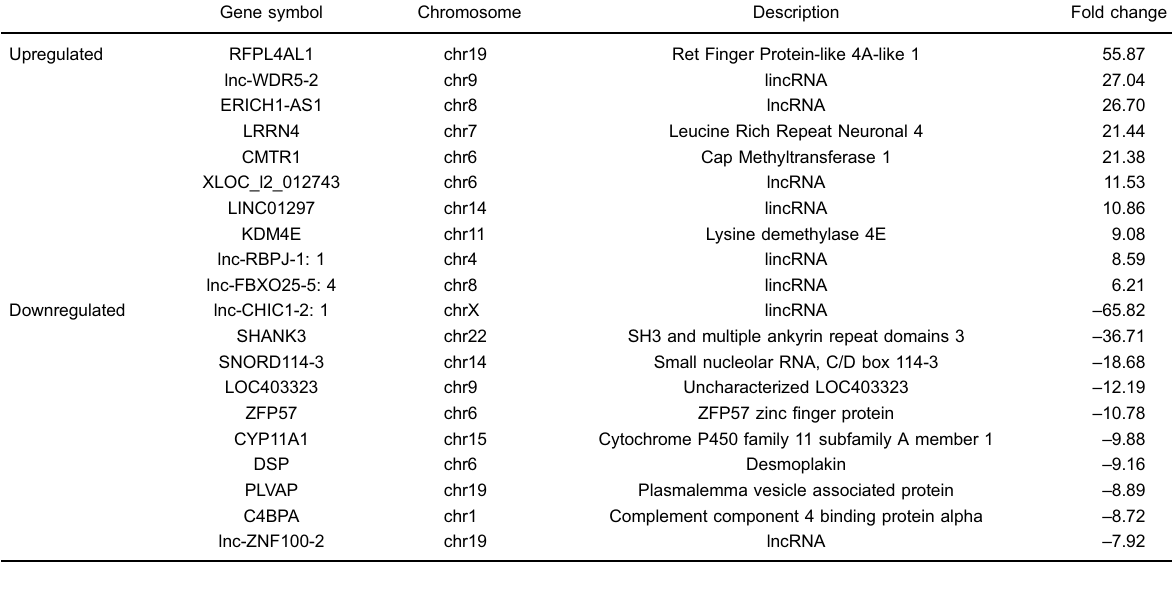
Table 3. Characteristics of the top 20 differentially expressed mRNAs in AHOL1 cell line sorted by fold change (fold change X 2 and P o 0.05).